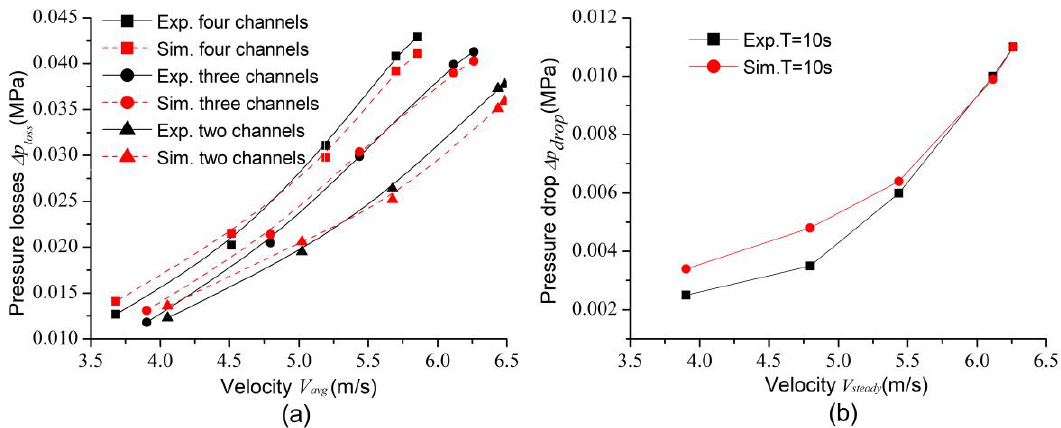
Figure 6. Comparison of experimental and numerical investigations: ( a ) pressure loss; ( b ) pressure drop.